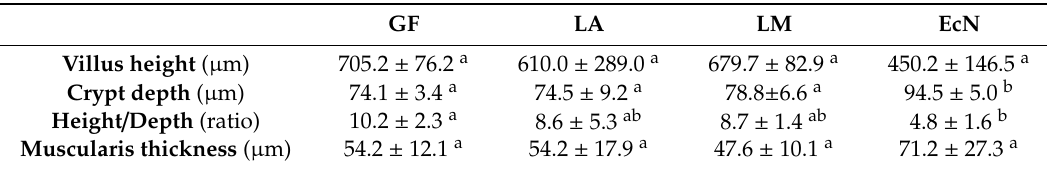
Di ff erences among villus height, crypt depth, ratio of villus height / crypt depth, and muscularis thickness in the terminal ileum in the germ-free (GF) piglets and the piglets mono colonized with L. amylovorus (LA), L. mucosae (LM), and E. coli Nissle 1917 (EcN) were evaluated by one-way analyses of variance (ANOVA) with Tukey’s multicomparison post-hoc test. The results are presented as mean ± S.D. The values with di ff erent letters significantly di ff er ( P < 0.05). Six piglets in each group were